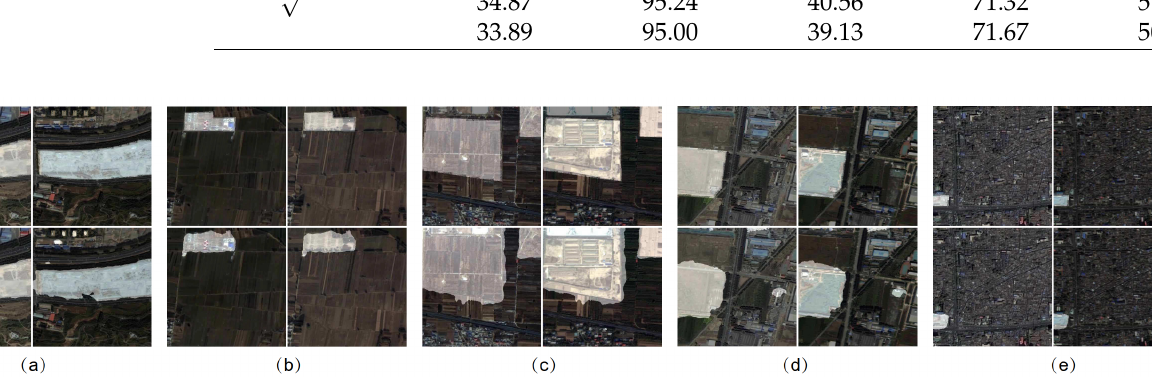
√ mean that the Decoder fuses the correspond-